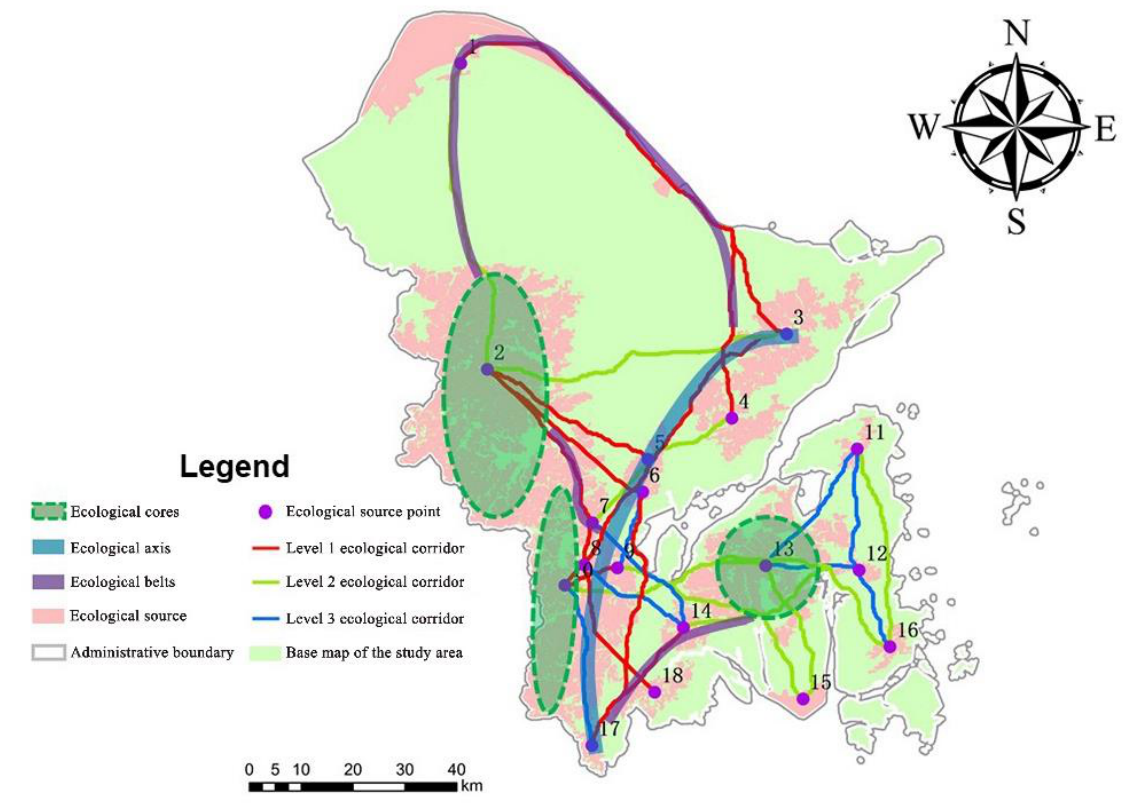
Figure 9. The optimization pattern of “one axis, three centers, and three Fig. 9. The optimization pattern of “one axis, three centers, and three belts”.